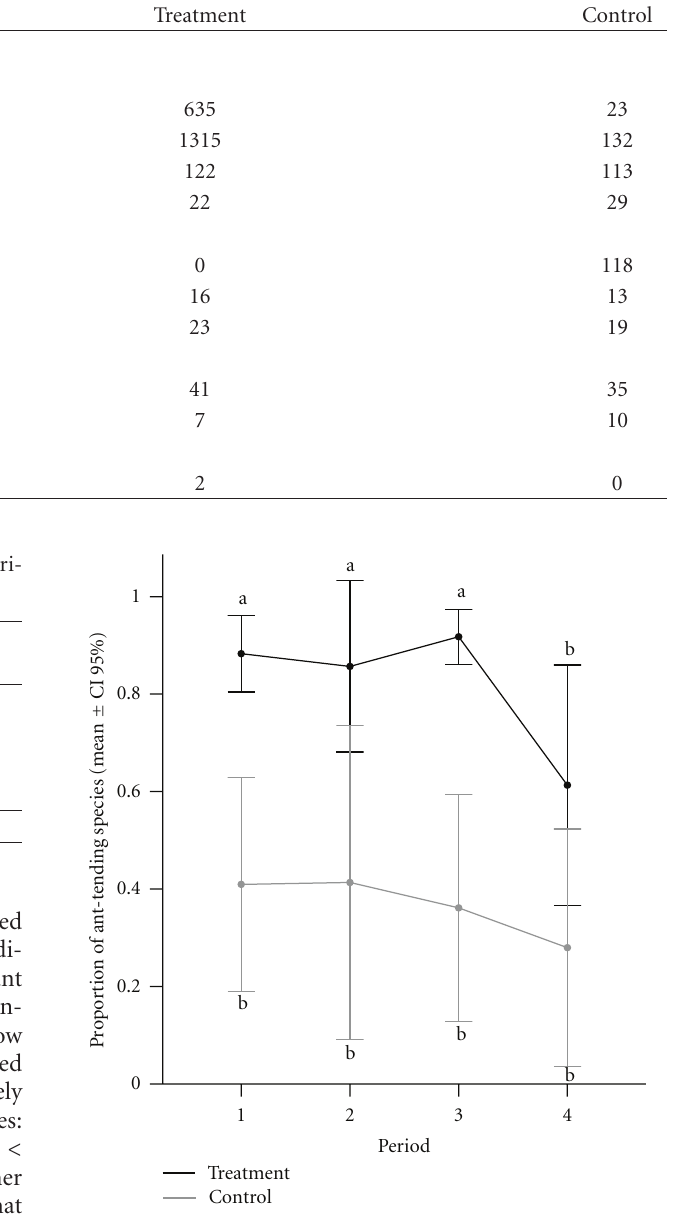
Total number of ants